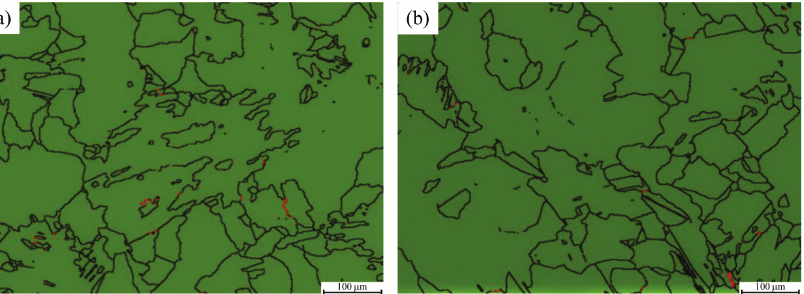
Figure 9: EBSD maps of different grain boundary near the tensile fracture deformed at (a) 900°C and (b)